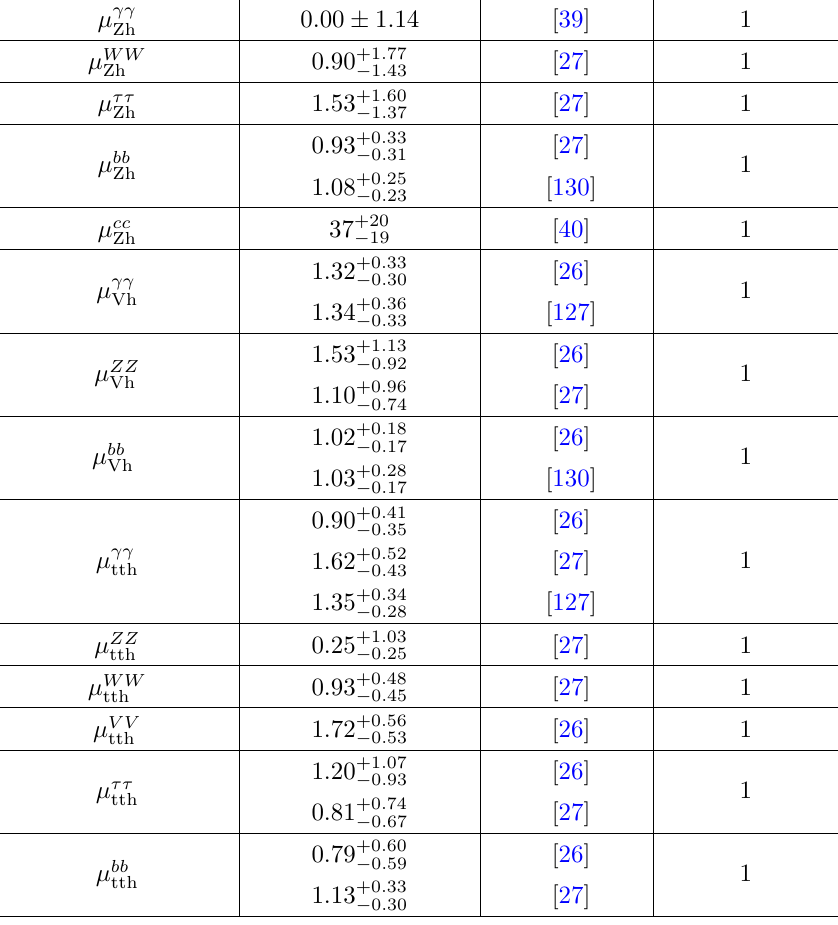
Table 4. Table of the Higgs signal strengths used in the analysis in section 5.